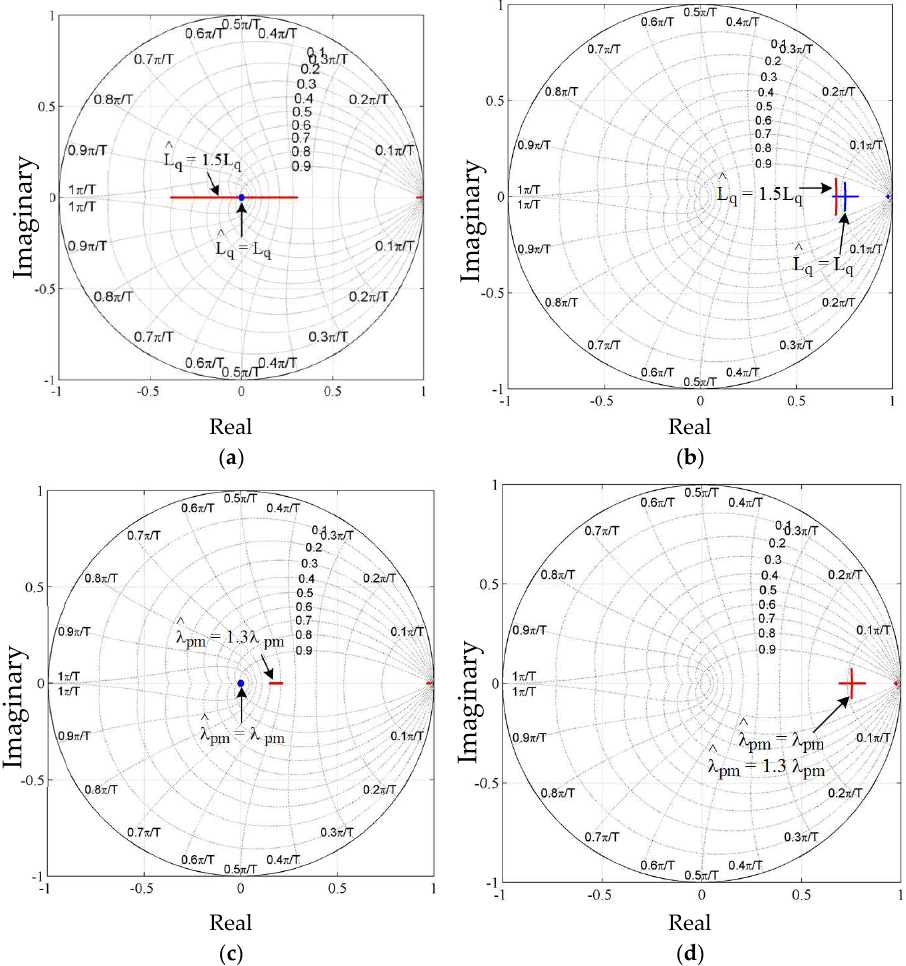
Figure 14. Eigenvalue (EV) migration of DB-DTFC and CVC along the US06 driving cycle when ˆ L q and ˆ λ pm are detuned by 50% and 30%, respectively. ( a ) When L q is detuned in DB-DTFC; ( b ) When L q is detuned in CVC; ( c ) When pm is detuned in DB-DTFC; ( d ) When pm is detuned in CVC. Both the DB-DTFC and the CVC IPMSM drives are shown to be operating at a stable region